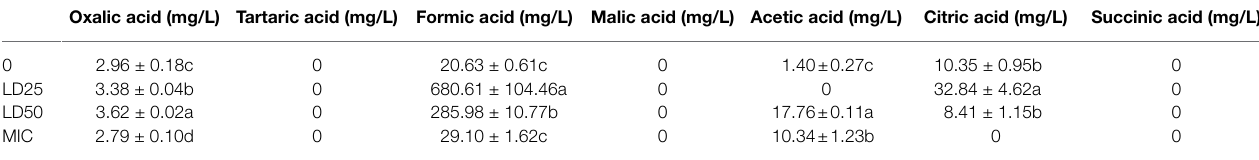
TABLE 1 | Organic acid production by strain PGP15 under different cadmium